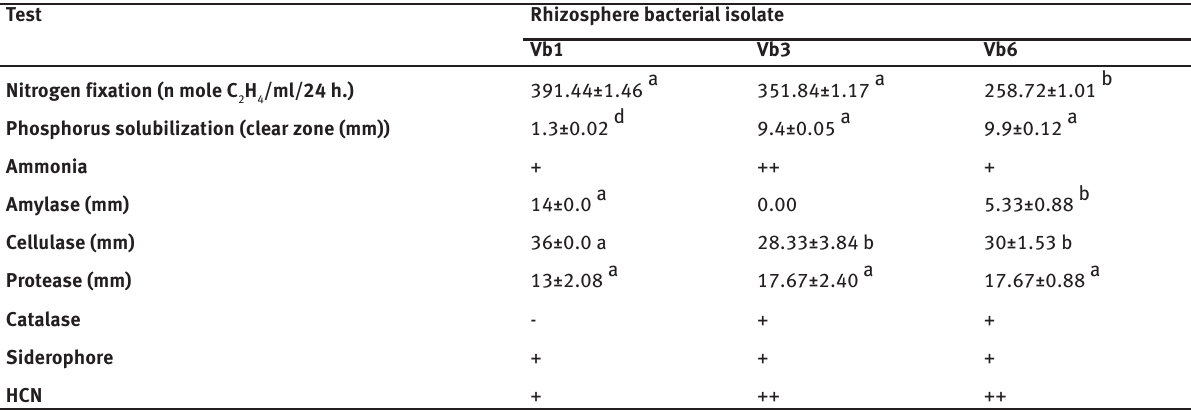
Nitrogen fixation (n mole C